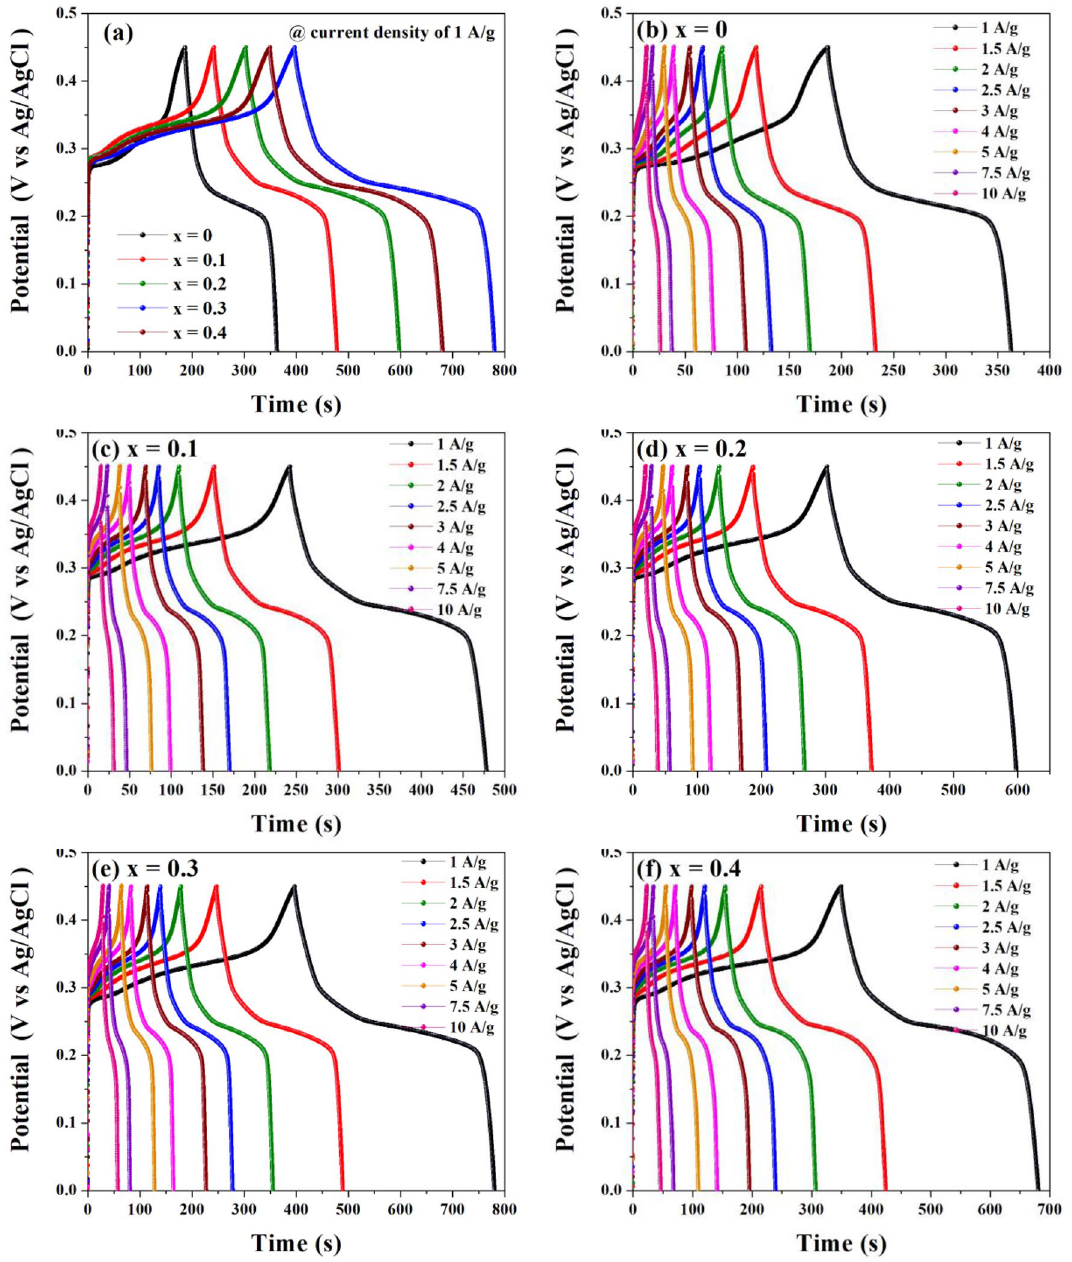
Figure 11. GCD curves of Co x Zn 1−x Fe 2 O 4 (x = 0.0–0.4) NPs electrodes measured at various current densities ( a ) 1 A/g and ( b )–( f ) 1–10